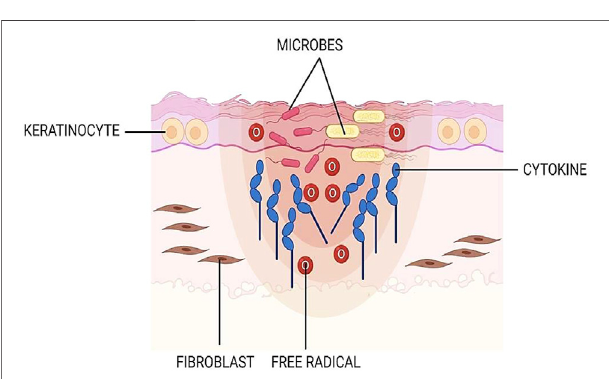
FIGURE 2 | Chronic wound. In the late-healing wound, there are excessive levels of bacteria, cytokines, and free radicals.